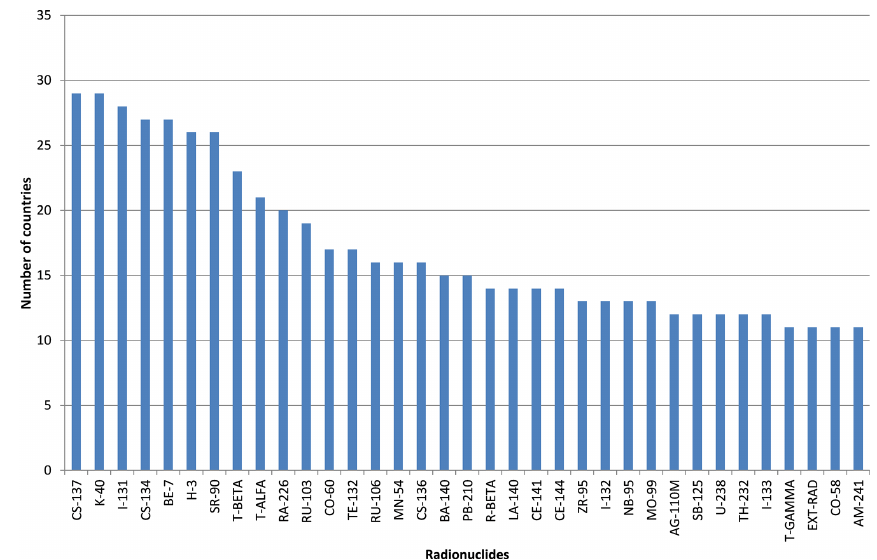
Figure 6. Number of countries providing information on a certain radionuclide to REMdb; the figure shows just those radionuclides with at least 10 countries reporting